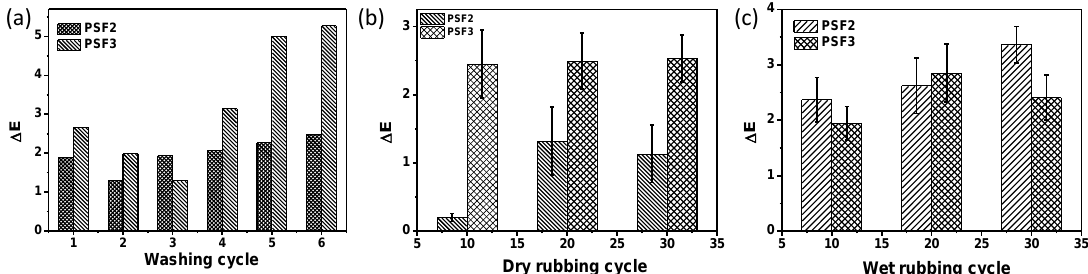
Figure 7. Evolution of color difference ( ∆ E) of the treated silk with PtNPs (PSF2 and PSF3) with ( a ) washing cycles, ( b ) dry rubbing cycles and ( c ) wet rubbing cycles.